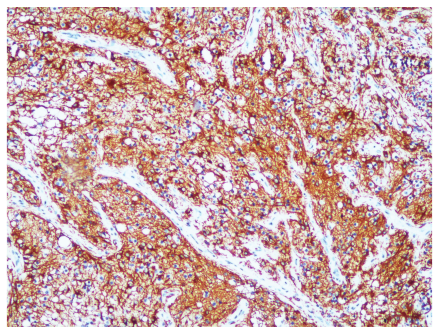
Figure 4: GFAP positivity in tumor